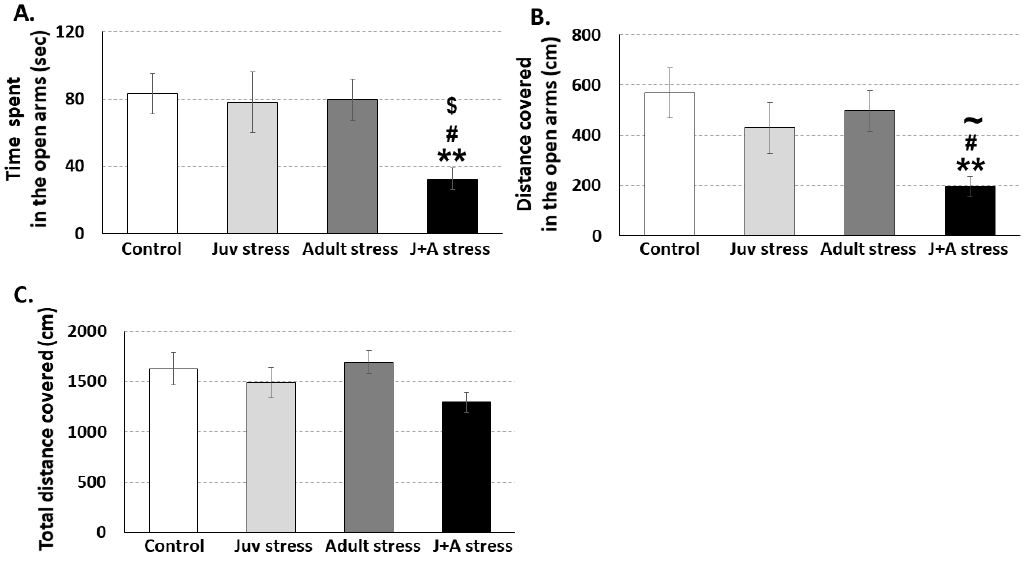
Figure 3. Rat behavior in the elevated zero maze (EZM) following exposure to the adulthood stress with or without preexposure to juvenile stress: J + A rats ( n = 14) spent less time in the open quadrants of the EZM compared to all other groups ( A ). J + A rats showed lower activity levels in the open quadrants of the EZM compared to control ( n = 14) and adult stress-exposed rats ( n = 14) and a trend towards reduced activity compared to juv stress exposed rats ( n = 14) ( B ). No significant reduction in total activity levels in the EZM was observed ( C ). ** Significant difference from control, p < 0.01; $ significant difference from juv stress, p < 0.05; # significant difference from adult stress, p < 0.05; and ~ border line significant difference from juv stress, p < 0.06.